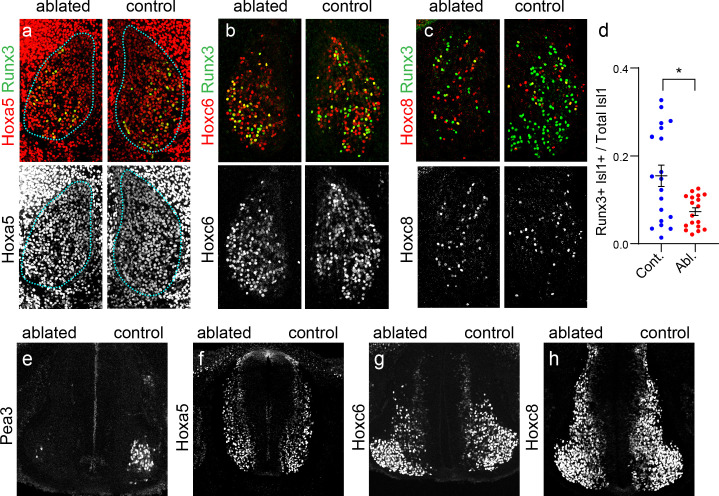
Hox expression in MNs and SNs is limb-independent.(a–g) Cross sections of St. 28 chick embryos after unilateral limb ablation. (a–c) Expression of Hoxa5 (a), Hoxc6 (a), and Hoxc8 (a) expressing SNs. Runx3 marks pSNs. There is a noticeable reduction in Runx3 expression on ablated side, especially in the Hoxc8+ domain. (d) Loss of Runx3 expression in SNs after limb ablation. The fraction of Isl1+ SNs expressing Runx3 was reduced from 15.5 ± 2.4% in controls (N = 3 animals) to 7.3 ± 0.9% after limb ablation (N = 3 animals, p=0.0038, Student’s t-test). (e) Limb ablation results in a loss of Pea3+ MNs compared to the contralateral side. (f–h) Similar patterns of Hoxa5 (e), Hoxc6 (f), and Hoxc8 (g) expression in MNs after limb ablation.